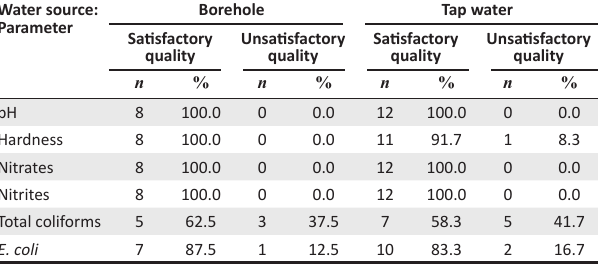
TABLE 2: Drinking water quality in layer farms supplied with either borehole or tap water in Matola and Maputo